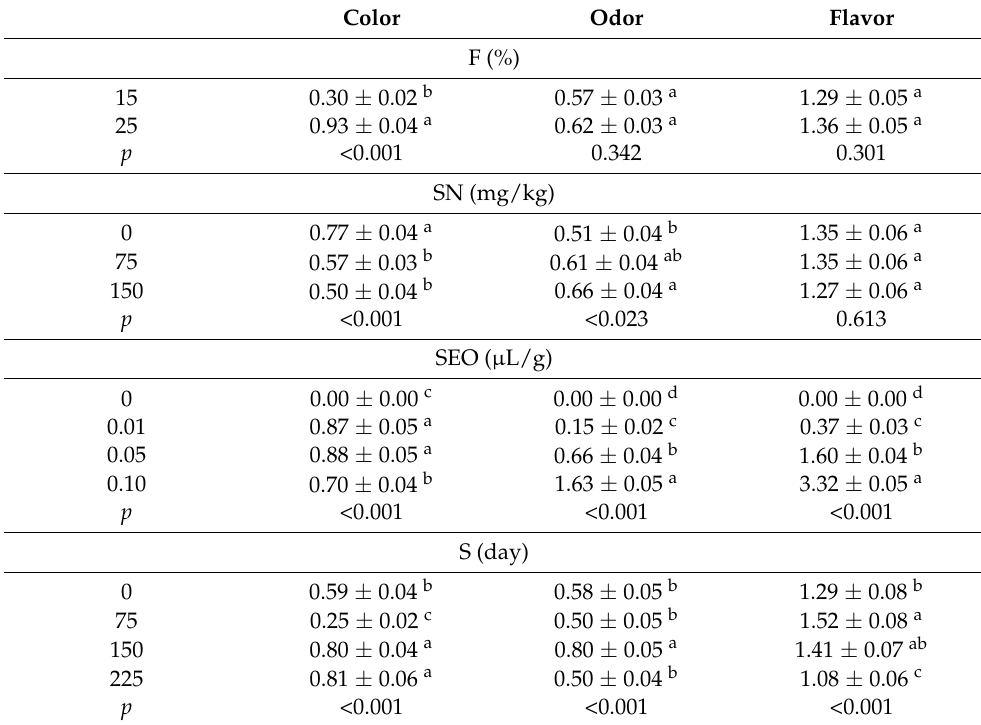
Table 7. Sensory parameters of DFS.